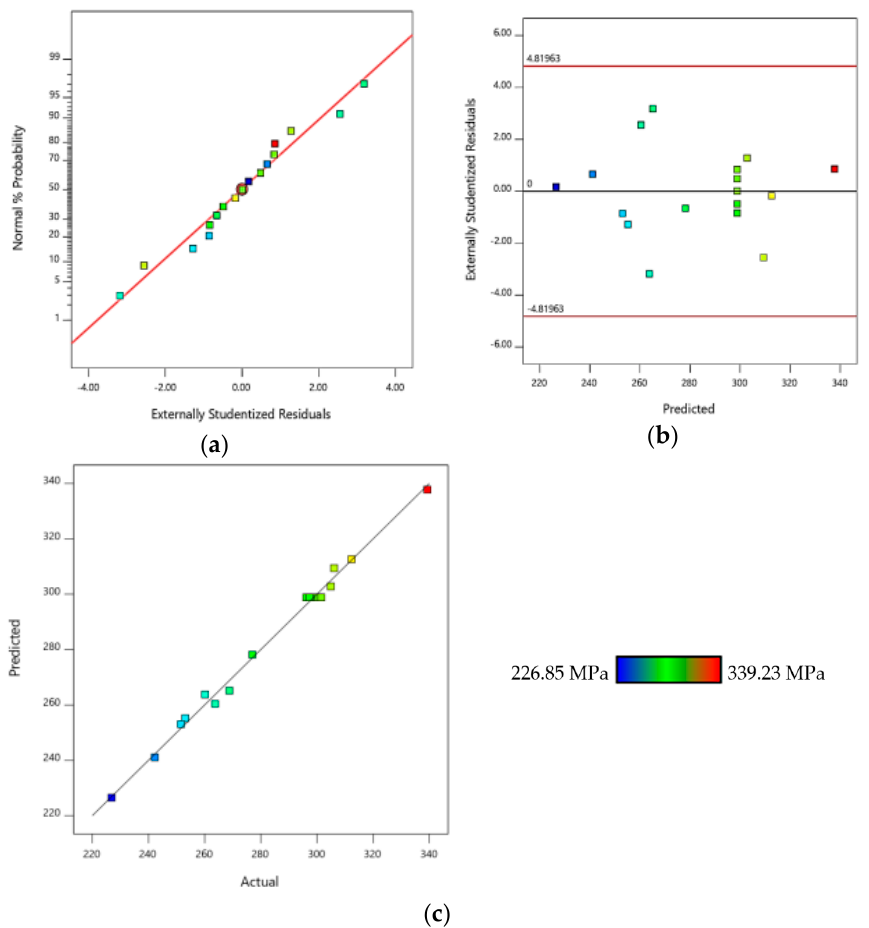
Figure 5. Diagnostic plots values of ( a ) normal probability versus residuals, ( b ) residuals versus predicted and ( c ) predicted versus actual of tensile strength bamboo reinforced epoxy composites.